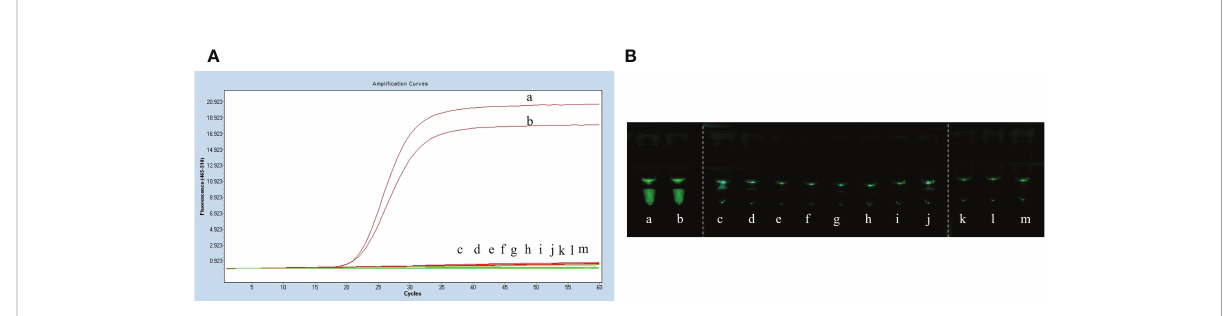
FIGURE 5 Speci fi city test results. (A) Speci fi city test real-time fl uorescence curve results. (B) Visualization of the Speci fi city results by using a 3D printed visual function box. (a) Streptococcus suis serotype 2 genomic DNA, (b) Streptococcus suis serotype 14 genomic DNA, (c) serotype 1/2, (d)